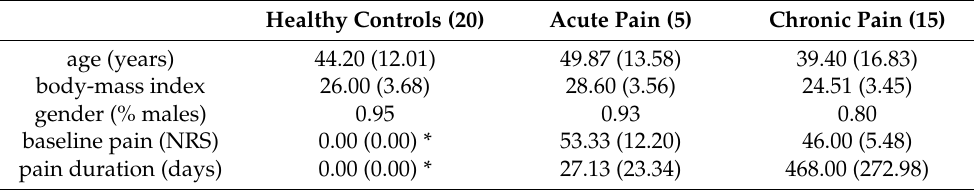
Table 1. Demographic and baseline pain characteristics of study participants.